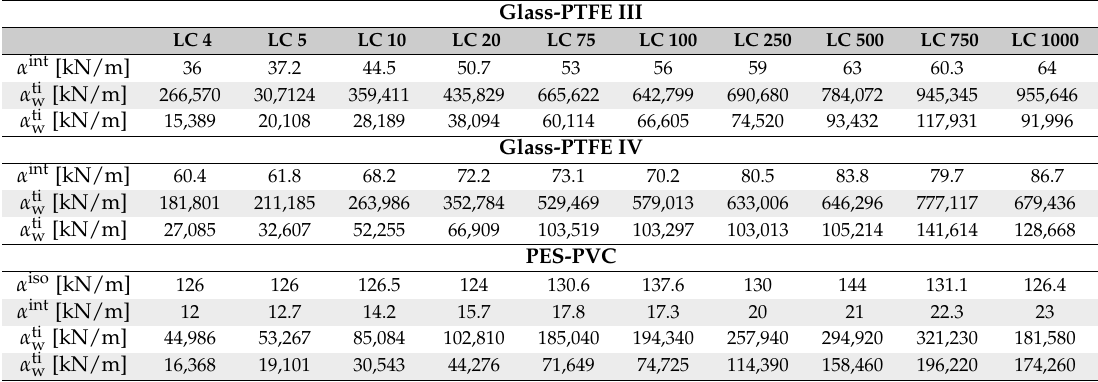
Table 4. Adjusted material parameters of the nonlinear material model.